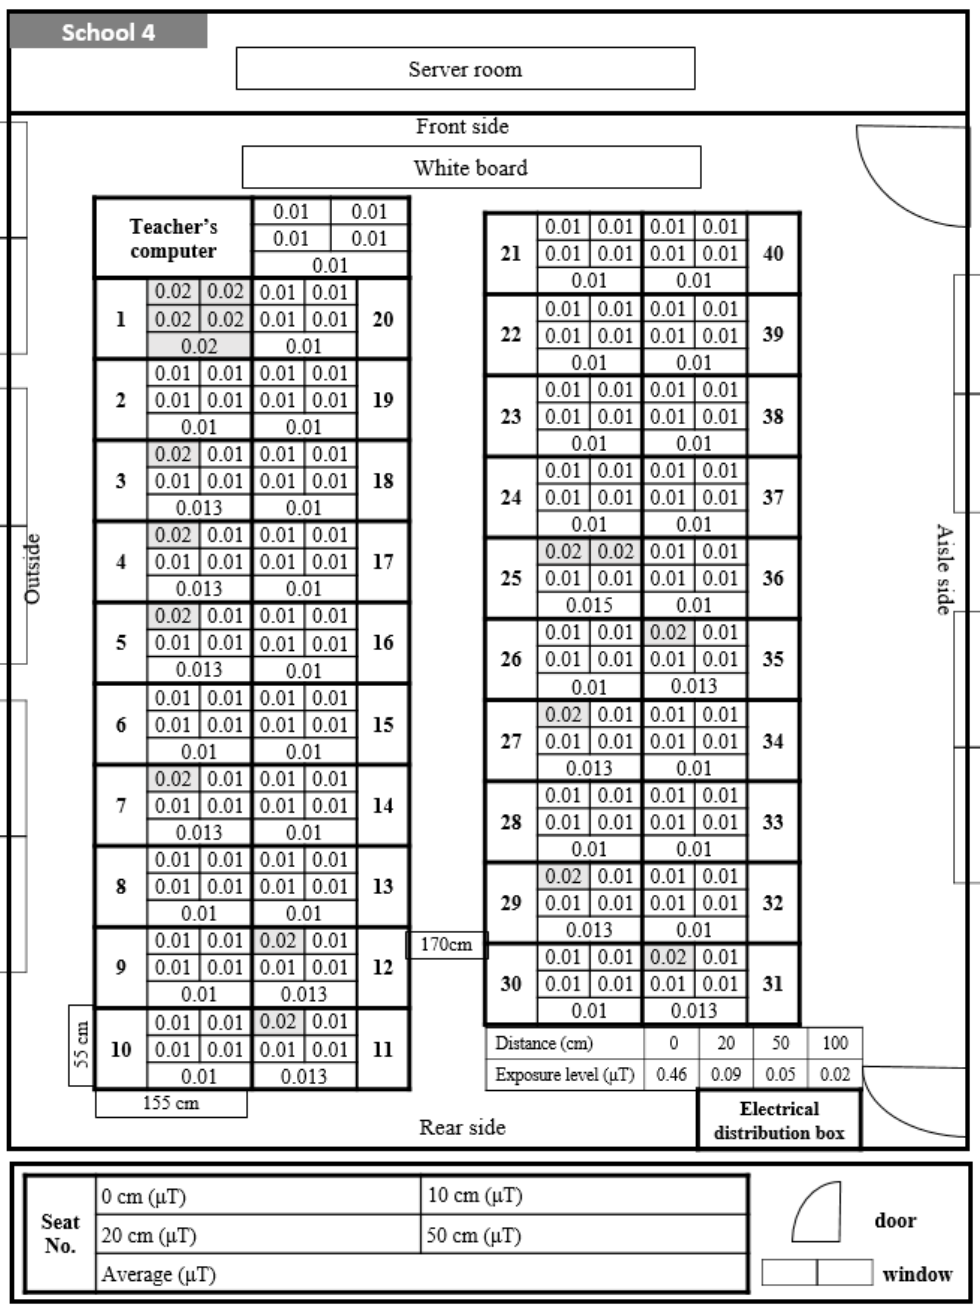
Figure 5. Distribution and exposure level of extremely low-frequency magnetic fields at each student seat in Classroom A at School 4. 0.01 is the lowest readout level, indicating < 0.01. The darkening of the space indicates that the level of ELF-MFs exposure increase by 0.01.